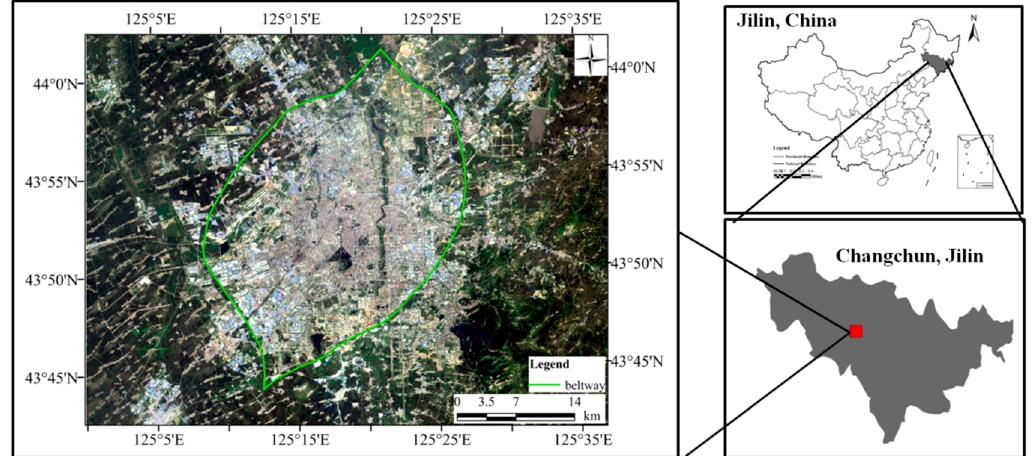
Figure 1. The location of Changchun City.